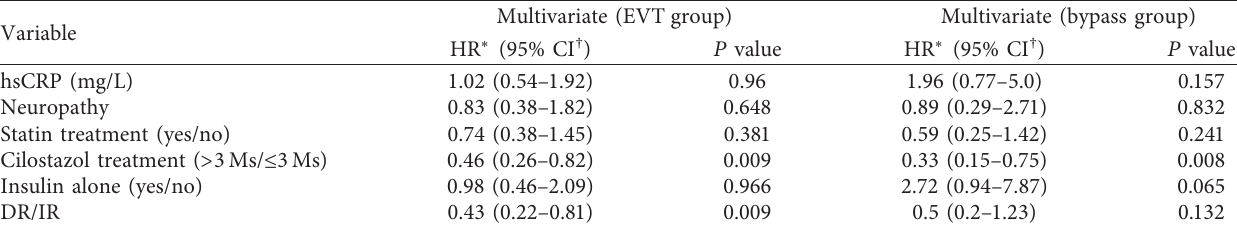
Table 5: Multivariate Cox regression analysis of primary patency in the two